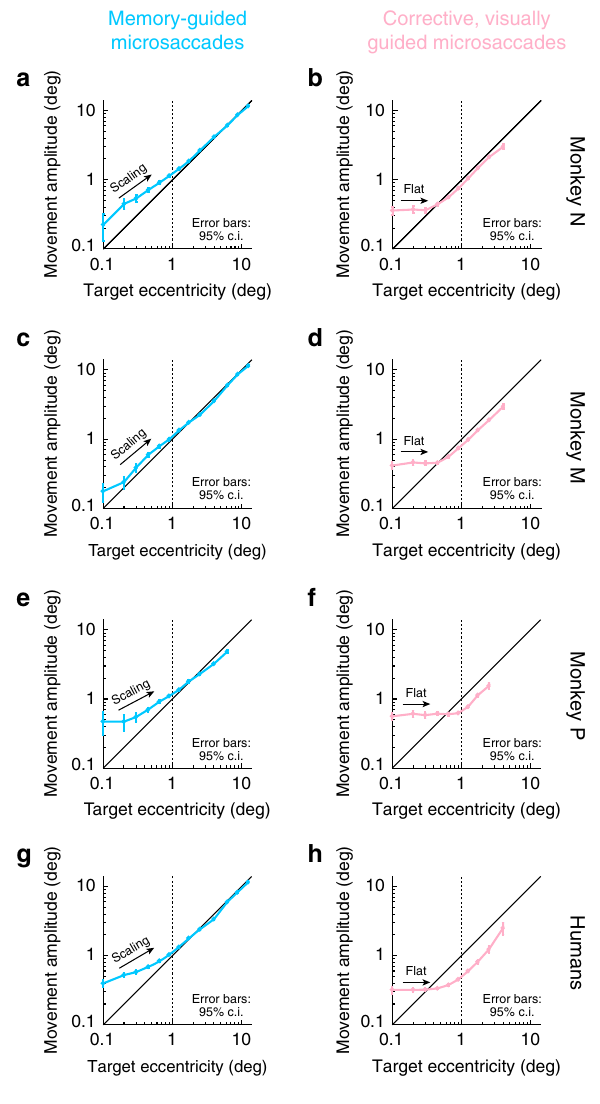
Fig. 4 Memory-guided microsaccade amplitudes scaled better with target eccentricity than corrective, visually-guided microsaccades. a For all target eccentricities in monkey N, we plotted memory-guided movement amplitude as a function of target eccentricity. The data below 1 o target eccentricity (vertical dashed line) are from the same trials described in Figs. 1 – 3 for reaction times, success rates, and directional accuracy. Here, we show their amplitude scaling. Memory-guided microsaccades increased in amplitude with increasing target eccentricity, consistent with them being genuine responses to task instruction, but they showed systematic overshoot (e.g. Figure 1). The overshoot disappeared for larger eye movements (also see Fig. 5 for a potential explanation).